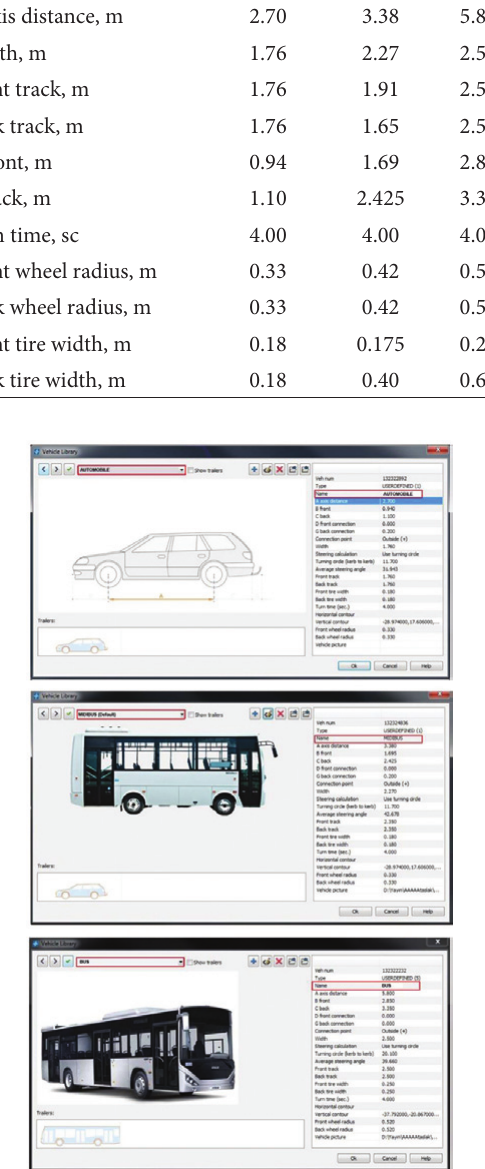
Fig. 2. Geographical location of the road No. 005 Table 3. Technical specifications for vehicle utilization types defined in vehicle library of Plateia 2013 software Technical specifications of